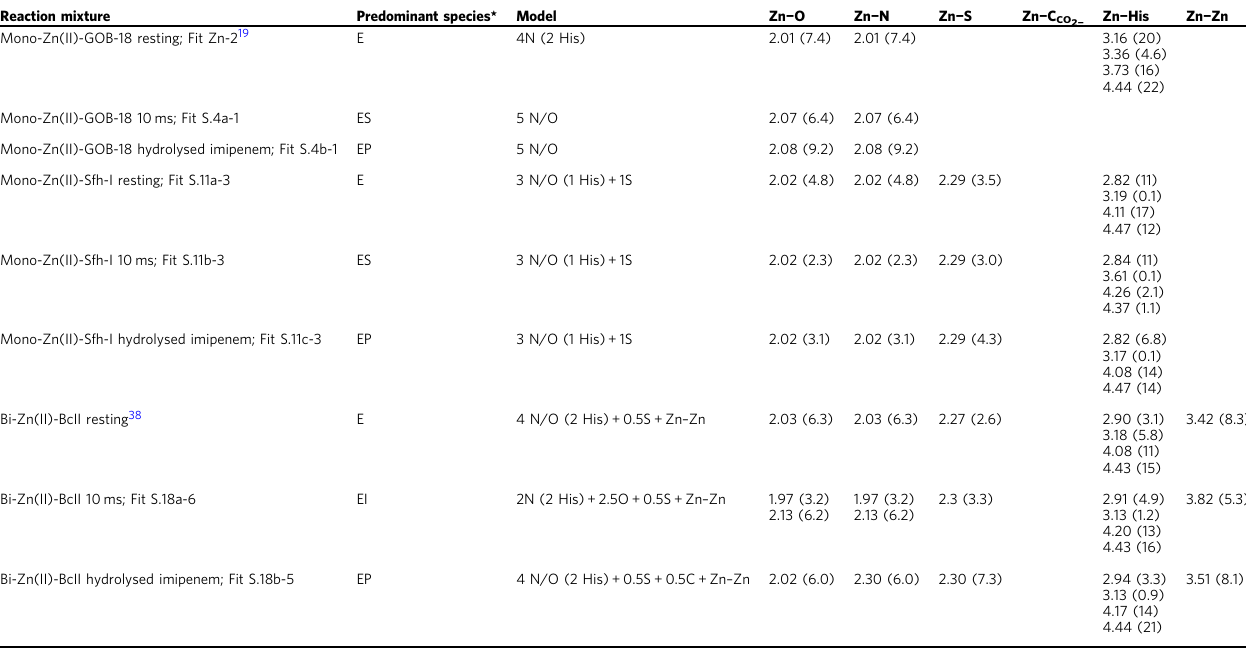
Table 1 Representative EXAFS fi ts for mono-Zn(II)-GOB-18, mono-Zn(II)-Sfh-I and bi-Zn(II)-BcII Reaction mixture Predominant species*